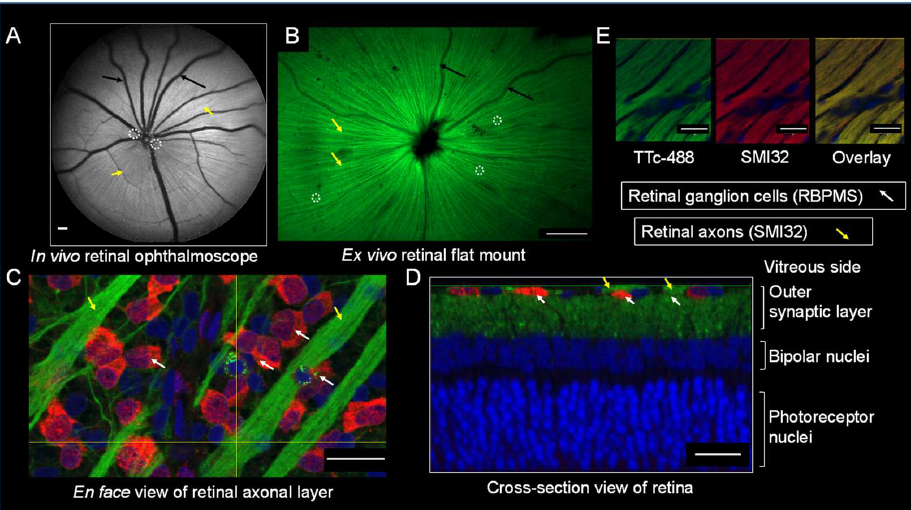
Figure 2. TTc-488 biomarker characterization. ( A ) An in vivo retinal ophthalmoscopic image of the eye fundus imaged with a confocal scanning laser ophthalmoscope (CSLO). Scale bar 200 µm. ( B ) An ex vivo retinal flat mount imaged with a widefield fluorescent microscope. Scale bar 500 µm. TTc-488, localizes to the RGCs presenting as small individual foci (white dashed circles) and also to the RAs in a linear radial pattern (yellow arrows) surrounding the vasculature, presenting as dark undulating lines (black arrows) centered on the optic nerve head (dark center), 3 h after an intravitreal injection. ( C ) Confocal imaging in the ganglion cell layer of retinal flat mount illustrates TTc-488 in the individual RAs arranged in bundles (green color, yellow arrows) and in RGCs (red color white arrows) as endovesicles in the perinuclear space in an en face view. ( D ) An optical cross-section view through the full thickness of the retina demonstrates the outer synaptic layer with extensive uptake of TTc-488 in the superficially located RGCs with their RA bundles interdigitating with bipolar dendrites, as well as the bipolar nuclei and photoreceptor nuclear layer. The localization of TTc-488 in RGCs was confirmed with anti-RBPMS-546 (red color, white arrows), a specific RGC cytoplasmic stain. (E) The co-localization of TTc-488 (green) in the RAs was confirmed with anti-SMI32-594 (red), reactive to a neurofilament H protein, which is a major constituent of axonal cytoskeletons. Scale bar 20 µm. TO-PRO 3 is a nuclear stain that outlines the distinct retinal nuclear layers (blue) demonstrating RGCs in the outer synaptic layer, bipolar nuclei, and photoreceptor nuclear layers. In vivo retinal ophthalmoscopic images were taken using auto contrast mode for morphological